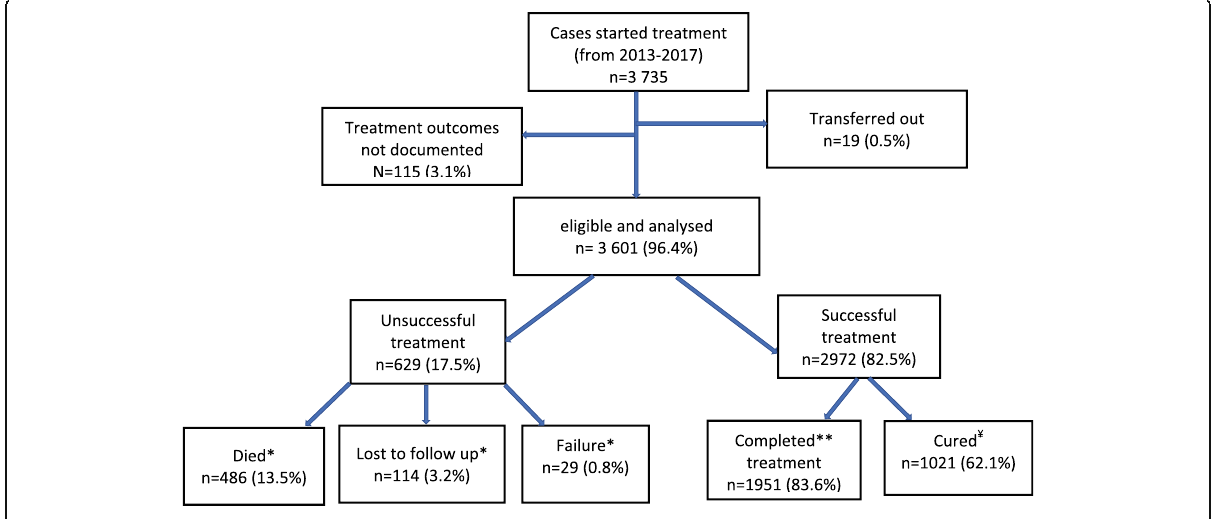
Fig. 4 Flow chart of TB treatment outcomes in 10 districts of the Volta Region, Ghana from 2012-2016